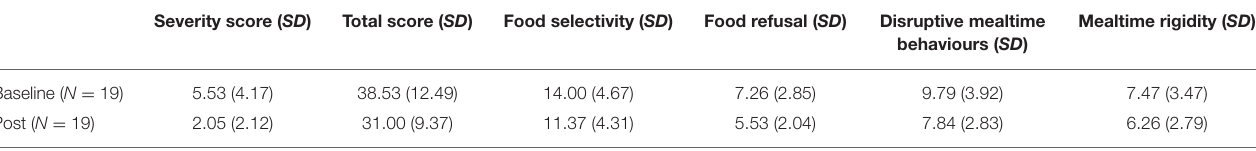
TABLE 2 | BAMBI scores for baseline and post intervention * .